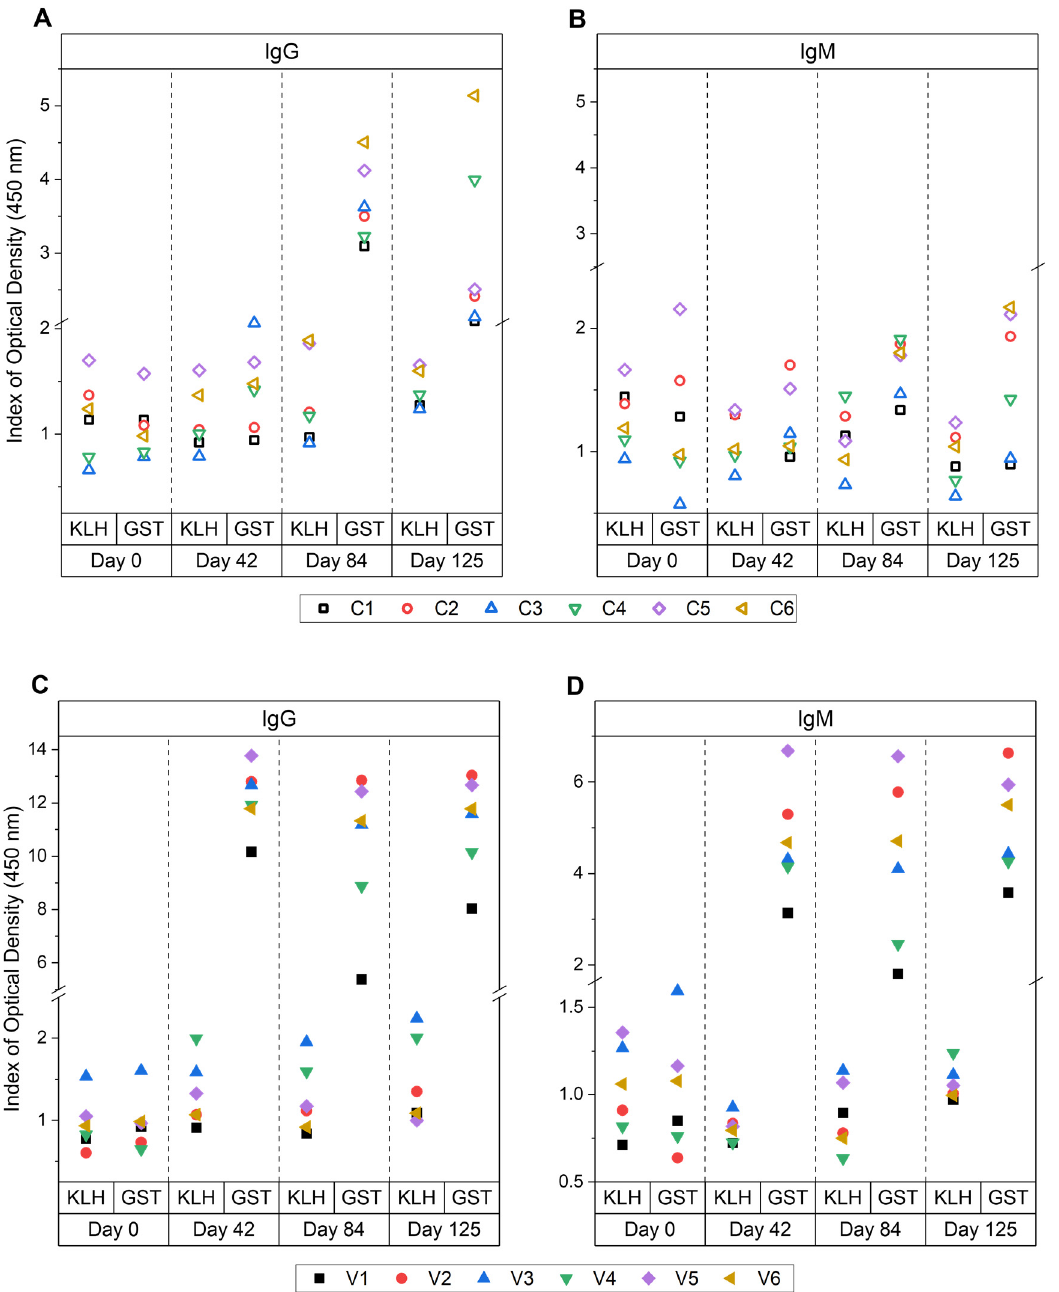
Figure 3. Individual antibody responses for animals within the control and vaccinated group in study A. ELISA responses to antigens KLH and native glutathione S -transferase (GST) from bovine serum samples from day 0 (naïve, pre-vaccination), day 42 (pre-challenge, post-vaccination), day 84 (6 weeks post-challenge) and day 125 (12 weeks post-challenge). Control group IgG ( A ), control group IgM ( B ), vaccinated group IgG ( C ) and vaccinated group IgM ( D ) responses are shown. Results are reported as the mean index ( n = 4) of optical density (450 nm) for the individual cows. The vaccination group received native GST and a tegumental antigen at day 0 and 28 in Freund’s complete adjuvant (FCA) then Freund’s incomplete adjuvant (FIA), and the control group received saline injections in FCA/FIA. Both groups were then challenged on day 42 with liver fluke metacercariae and sacrificed 12 weeks after challenge. All cut-off values fell below 0.07 for all assays.